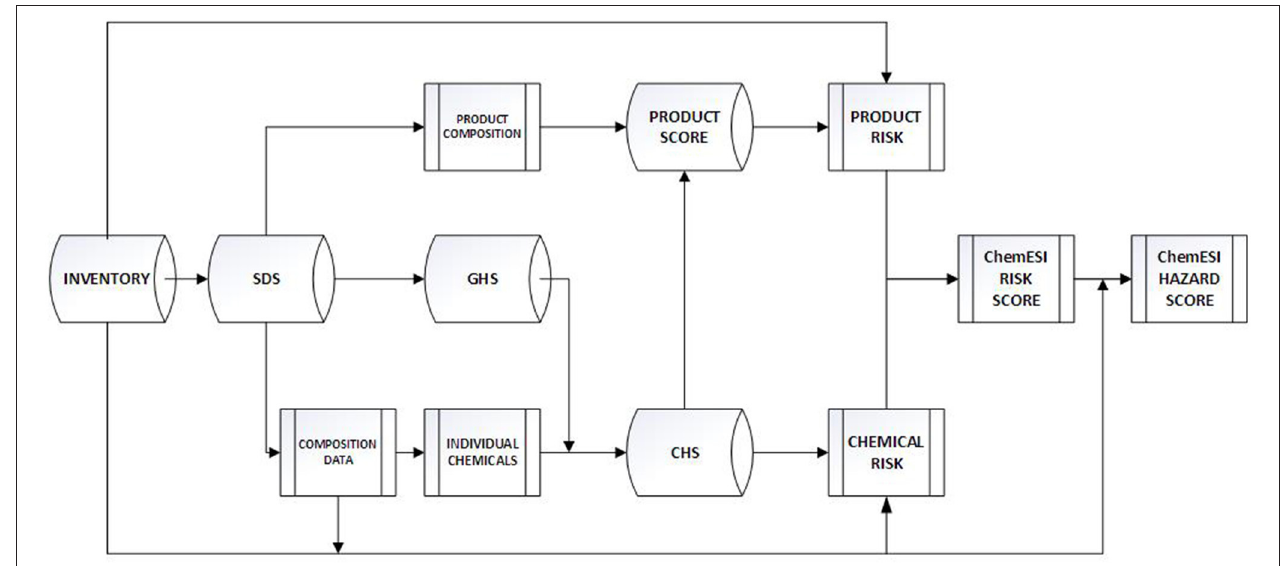
FIGURE 1 | ChemESI workflow.